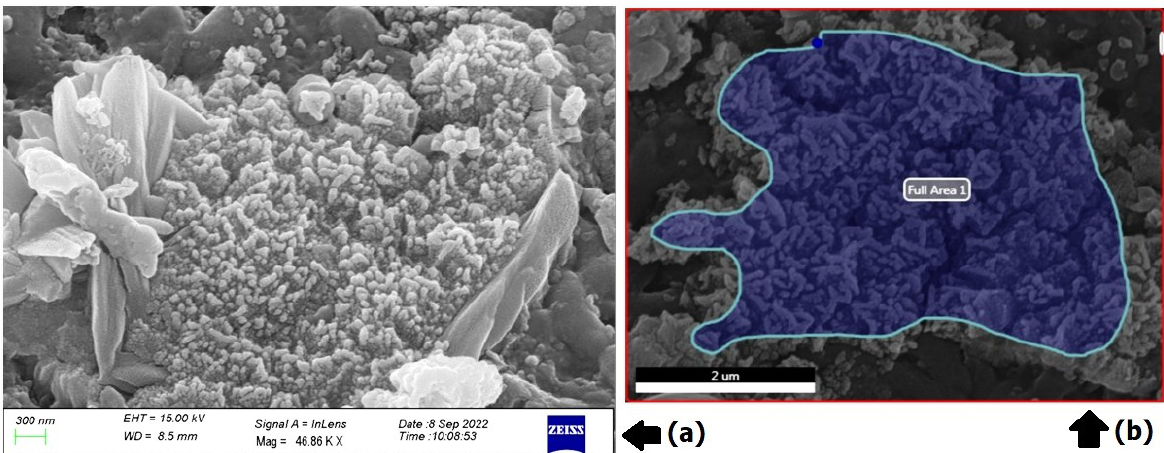
Figure 6. TEM analysis showing different sizes of Cu -Mn bimetallic nanoparticles with an average particle size of 50 nm. Scale bar indicates 100 nm. 3.7. Cytotoxicity Analysis The cytotoxicity of green synthesized CMBNPs was determined by using a NRU col- orimetric assay. This assay is based on the capacity of live cells to bind and integrate neu- tral red into lysosomes [29]. The cytotoxicity was measured as a concentration-dependent reduction in the uptake of neutral red in response to CMBNP exposure and serves as a